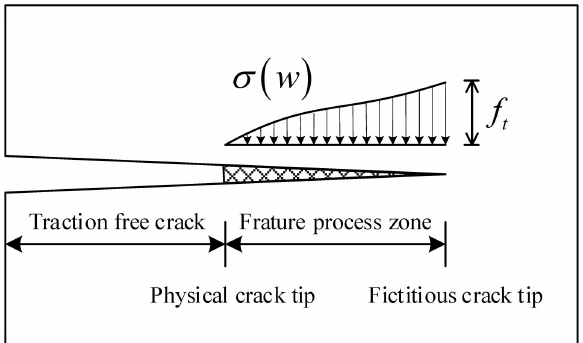
Figure 1. The composition of a concrete crack